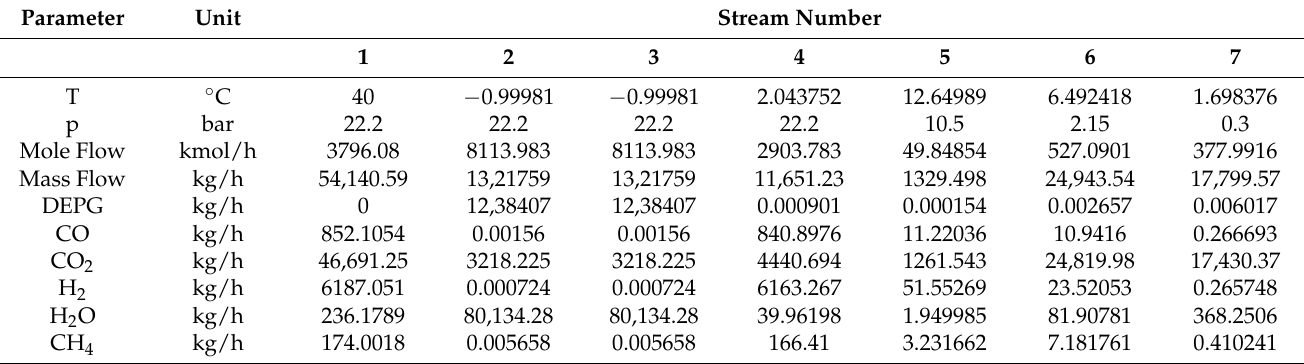
Table A6. Mass/Mole flows of Selexol process for ATR outlet gas with temperature and pressure state. Parameter Unit